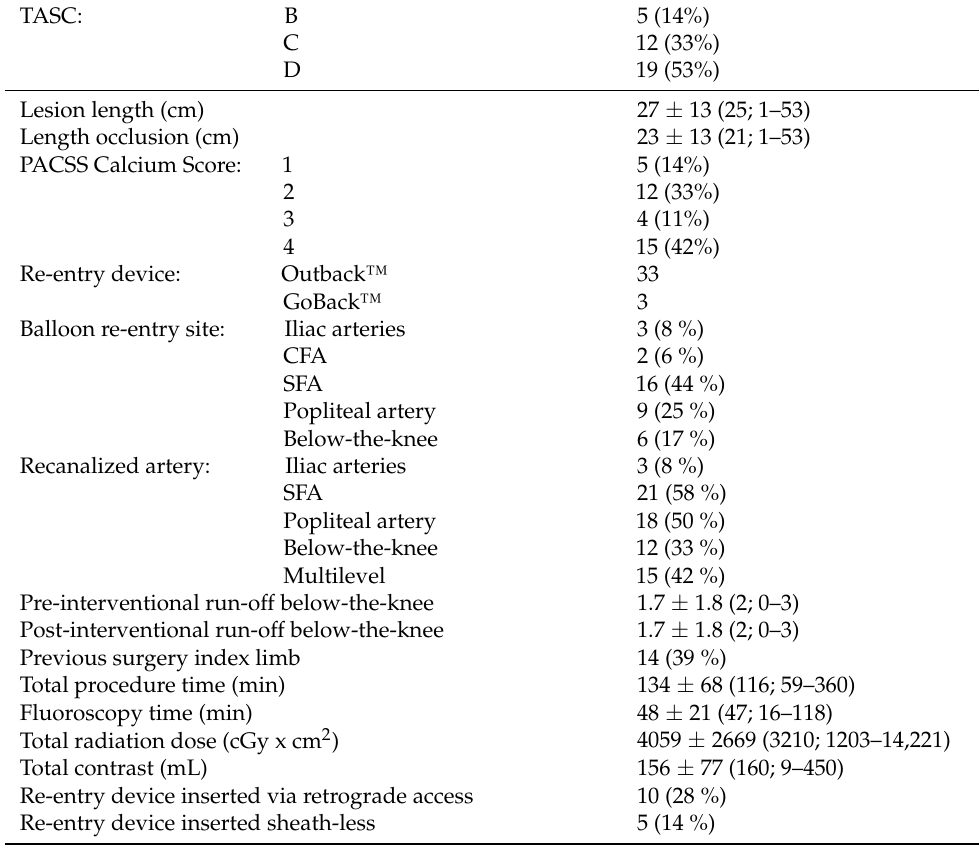
Table 2. Lesion and procedural characteristics (n =